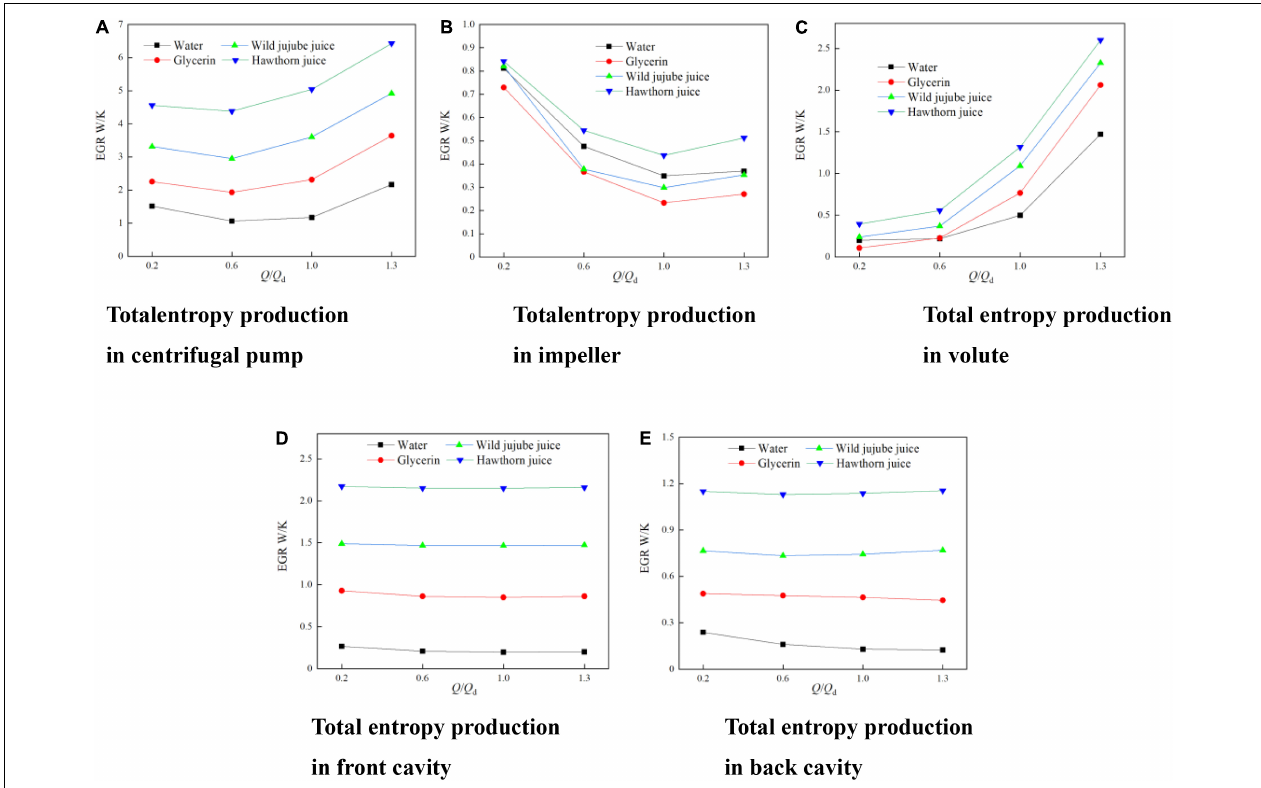
FIGURE 15 | Entropy production in each fluid domain of centrifugal pump with different viscosities. (A) Total entropy production in centrifugal pump, (B) Total entropy production in impeller, (C) Total entropy production in volute, (D) Total entropy production in front cavity and (E) Total entropy production in back cavity.